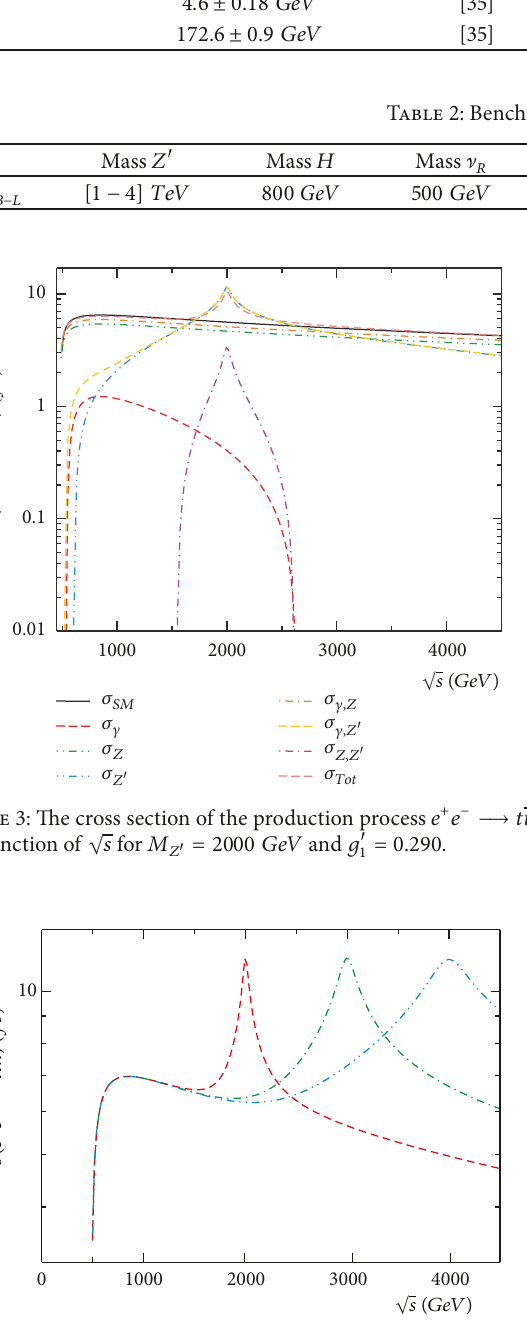
= 2000 𝐺𝑒𝑉 and 푍 󸀠 = 0.435 , and 𝑀 = 4000 𝐺𝑒𝑉 푍 󸀠 1